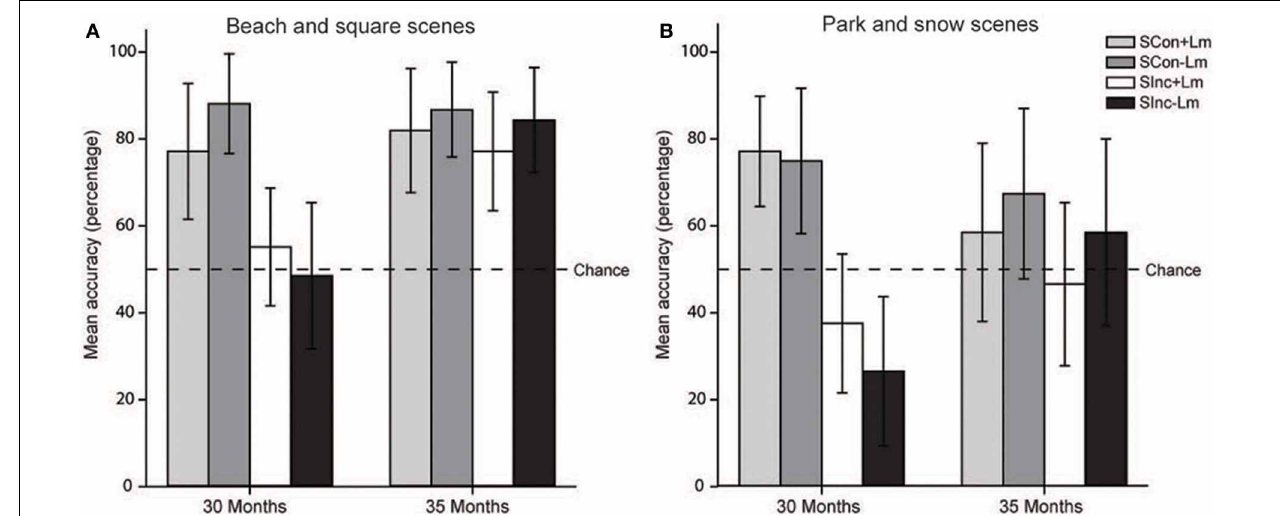
FIGURE 4 | Spatial orientation task performance after split on scene type. Mean accuracy scores and 95% confidence intervals by age group and condition after split on type of scene, which either (had) contained (A)